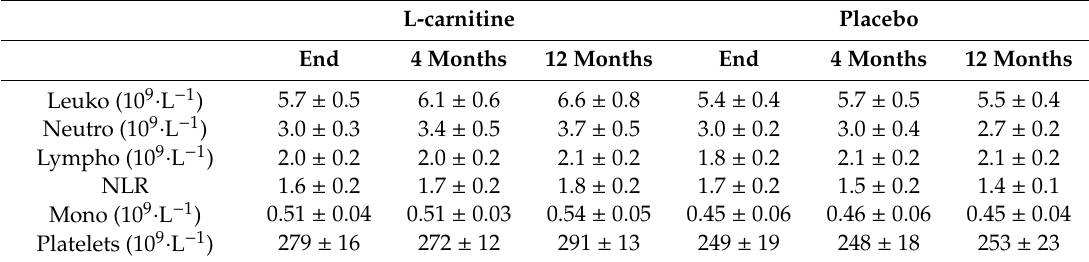
Table 2. Circulating white blood cell counts in L-carnitine and placebo groups after 24 weeks of supplementation (end) and 4 and 12 months after cessation of supplementation.